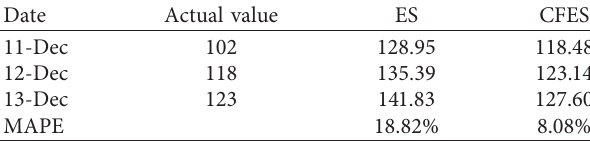
Table 1: Comparison of CFES and ES prediction